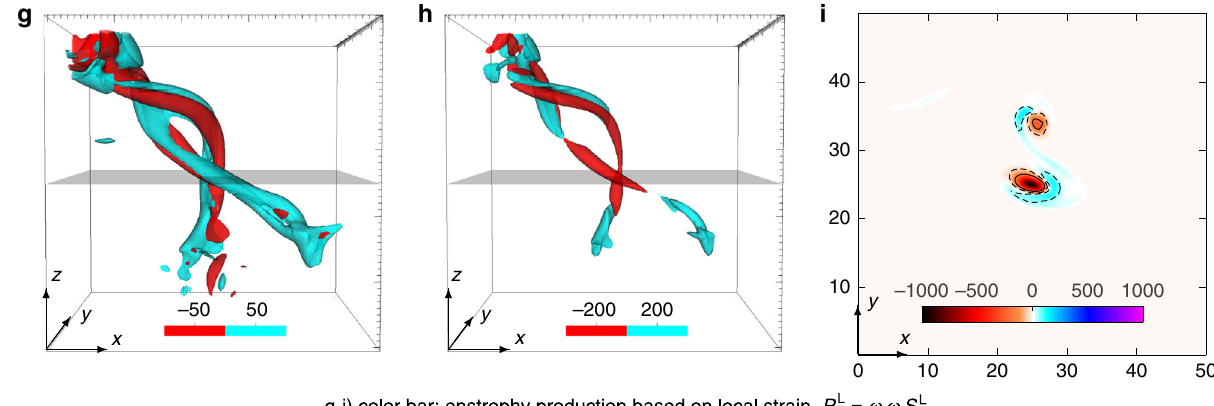
Fig. 1 Prevalence of negative local stretching in regions of intense vorticity. The panels focus on a representative region of intense vorticity from the numerical simulation at Taylor-scale Reynolds number R λ = 650 on a 8192 3 grid or equivalently (4096 η ) 3 , where η is the Kolmogorov length scale. The maximum enstrophy (vorticity-squared) is at the center of the domain shown, whose edges are 50 η in each direction (in each panel successive major ticks are 10 η apart). Top row: isosurfaces of enstrophy at thresholds of a 200, and b 1000 (times the mean value). c 2D contours of enstrophy at the mid-plane of the domain, shown in gray in a and b . Middle row: enstrophy production based on total strain, suitably non-dimensionalized by mean of enstrophy, at thresholds of d ±400, and e ±1000, which approximately correspond to moderate and intense enstrophy, shown in a and b , respectively. f 2D contours at the mid-plane. The production terms based on total strain is overwhelmingly positive. Bottom row: enstrophy production based on local strain (for R = 2 η ), once again suitably non-dimensionalized by mean enstrophy, at thresholds of h ±50, and g ±200, and also corresponding to moderate and intense enstrophy shown in a , b , respectively. i 2D contours at the mid-plane, revealing that the production term based on local strain is strongly negative in the regions of intense vorticity. For each row, the thresholds shown in fi rst two isosurfaces plots are marked by dashed and solid lines respectively in last 2D contour fi eld